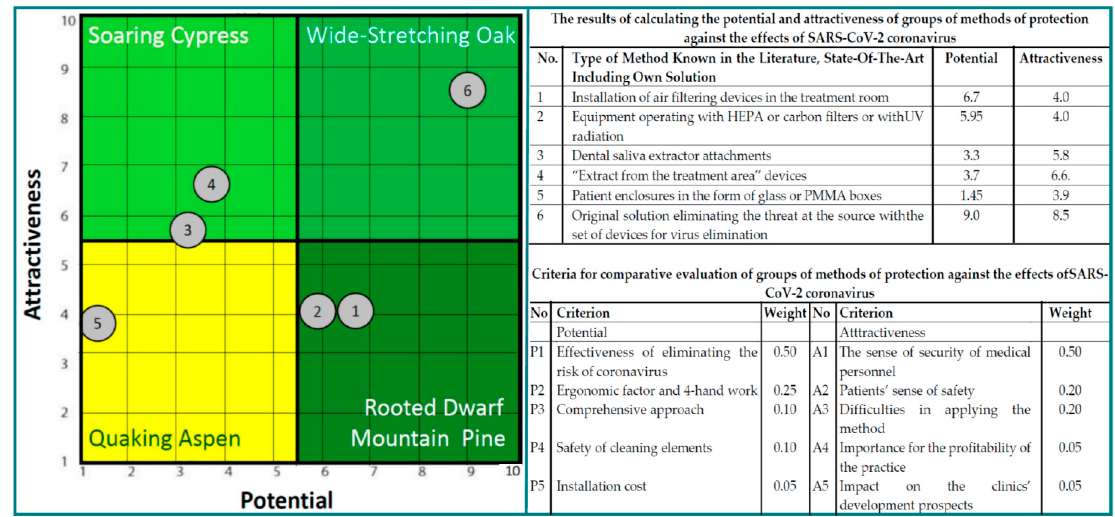
Figure 11. Results of a comparative analysis of various methods of protecting medical staff against the harmful effects of the SARS-CoV-2 coronavirus.